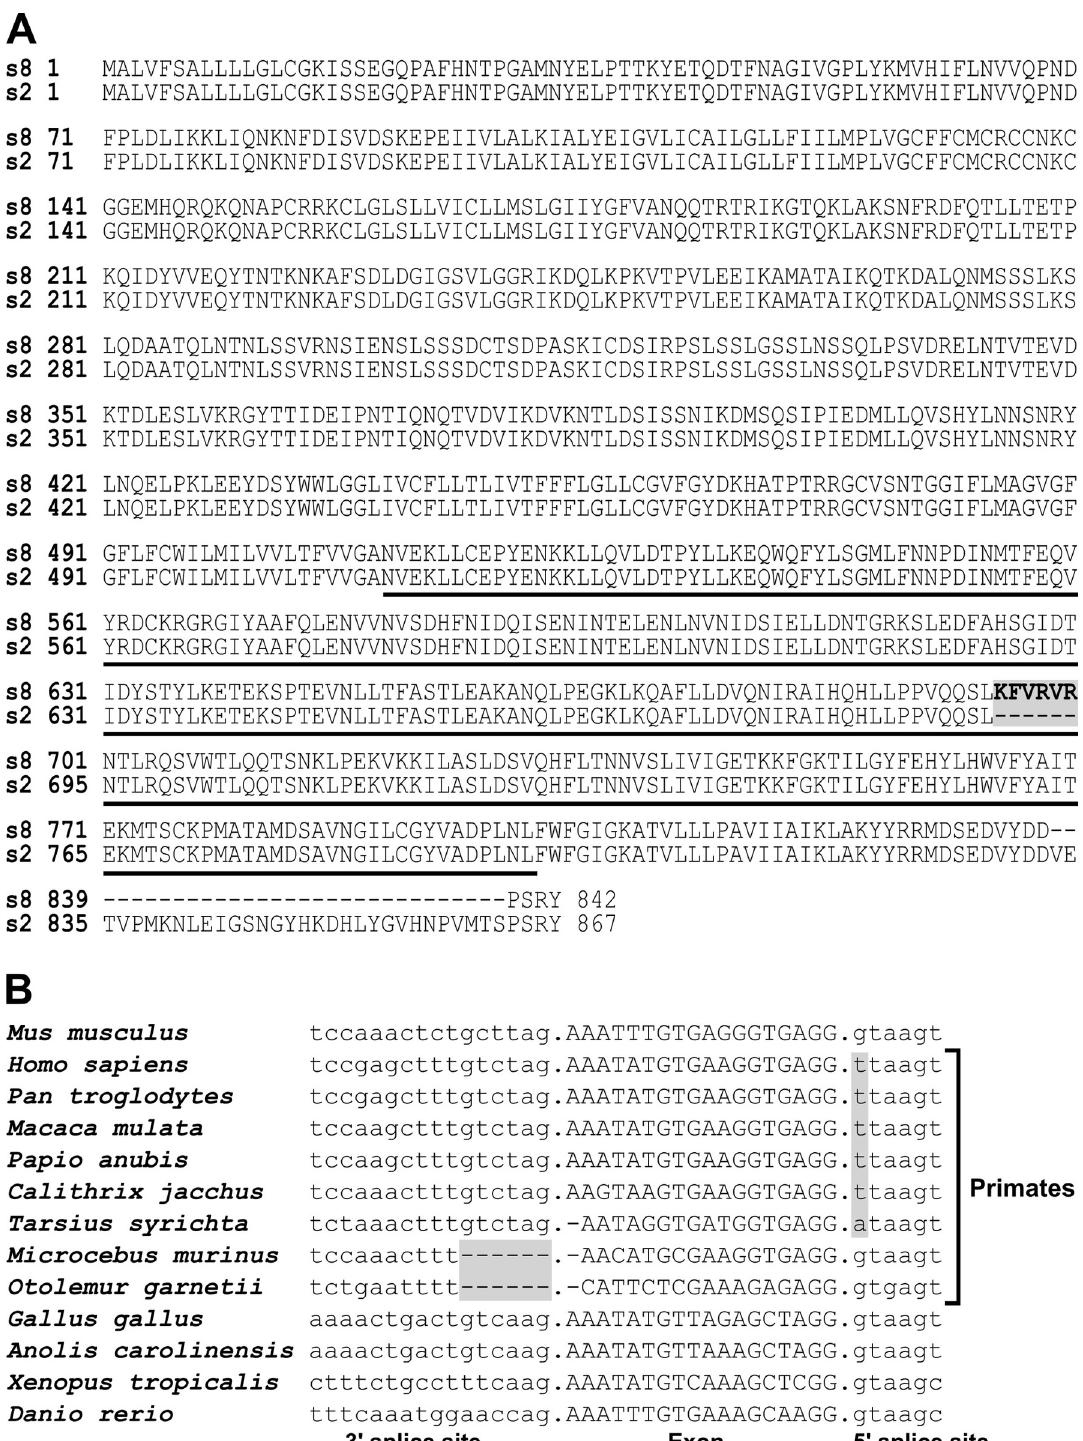
PLOS ONE | https://doi.org/10.1371/journal.pone.0274958 October 10,